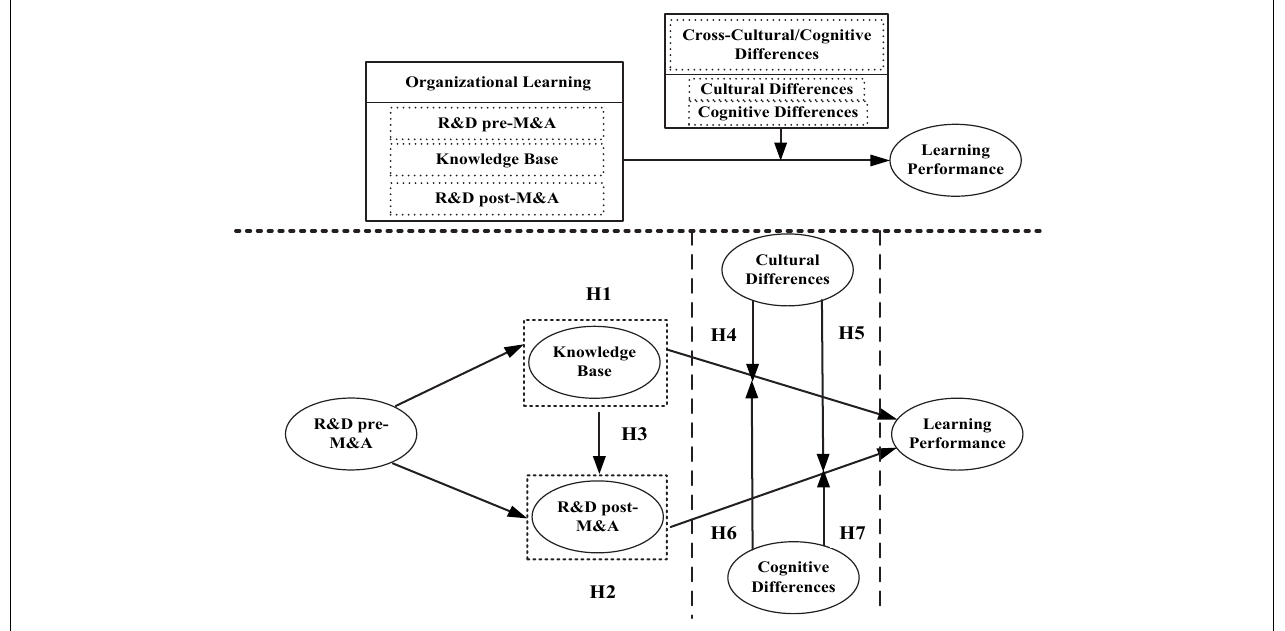
FIGURE 1 | The theoretical model of organizational learning mechanism research of technology-acquiring cross-border M&A of